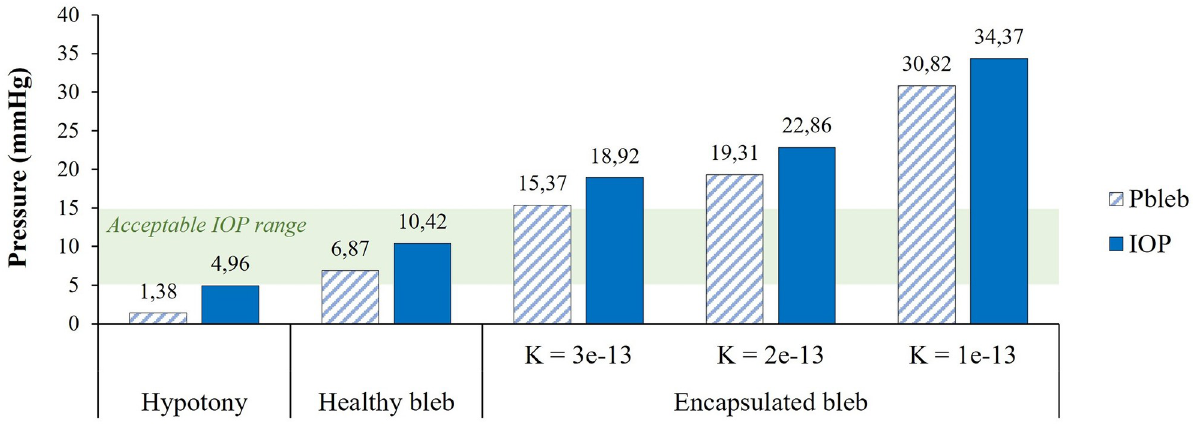
Fig 8. Bleb pressure ( p bleb ) and IOP calculated for each of the case-scenarios studied: Hypotony, healthy bleb, and encapsulated bleb. For the latter case, the hydraulic conductivity of the scar layer varies from 1 − 3x10 − 13 m 2 s − 1 Pa − 1 . In all cases, the PRESERFLO MicroShunt is used as the glaucoma drainage device. The shaded green area represents an acceptable IOP range of 5–15